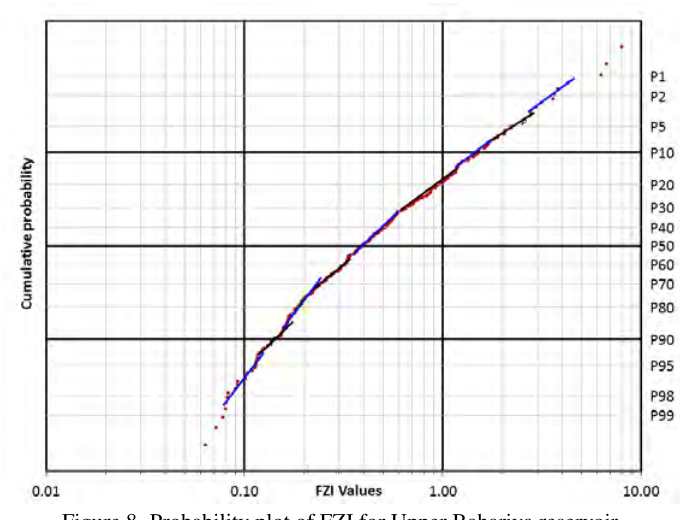
Figure 8. Probability plot of FZI for Upper Bahariya